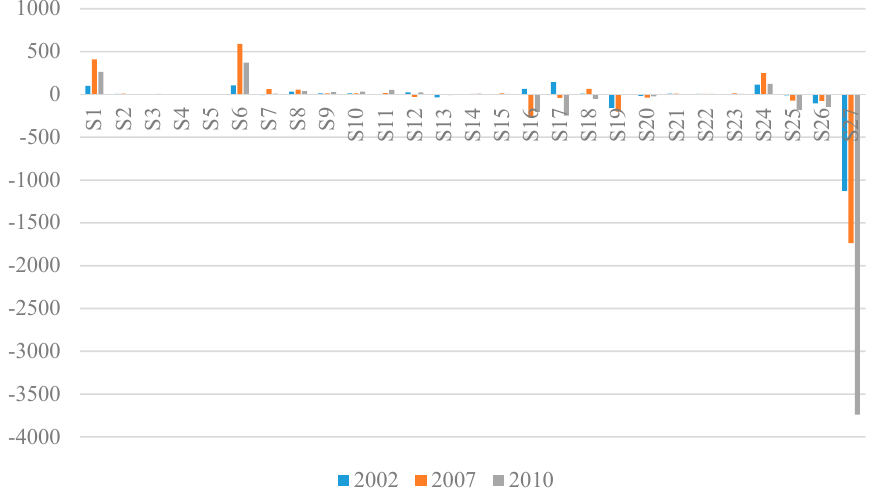
Figure 5. Net trade volume input to Beijing for industries in 2002, 2007, and 2010 (10 thousand yuan).